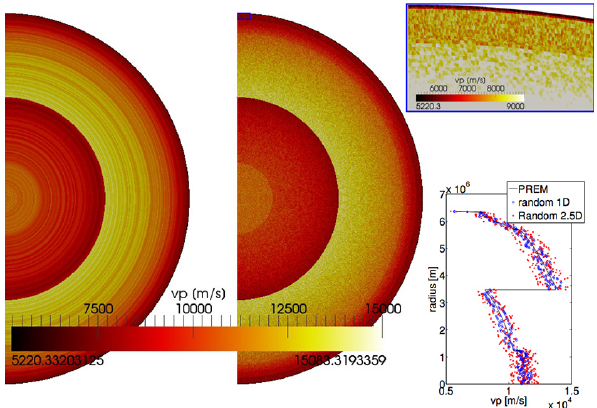
Figure 10. An example of various lateral heterogeneities, repre- senting realistic deep-mantle structures projected onto the source– receiver plane with azimuthal invariance. The large volume in yel- low denotes a Large Low-shear wave Velocity Province (LLSVP), flanked by two exaggerated ultra-low velocity zones (50km height, 10% P velocity decrease, 20% S velocity decrease, 10% density increase) underlying a detached uprising in the mid-mantle. The im- plementation is done by assigning laterally heterogeneous proper- ties to the coefficients of the basis functions, as commonly done in high-order spectral-element methods (Peter et al., 2011) so long as elements are sufficiently small to capture variations in a smooth